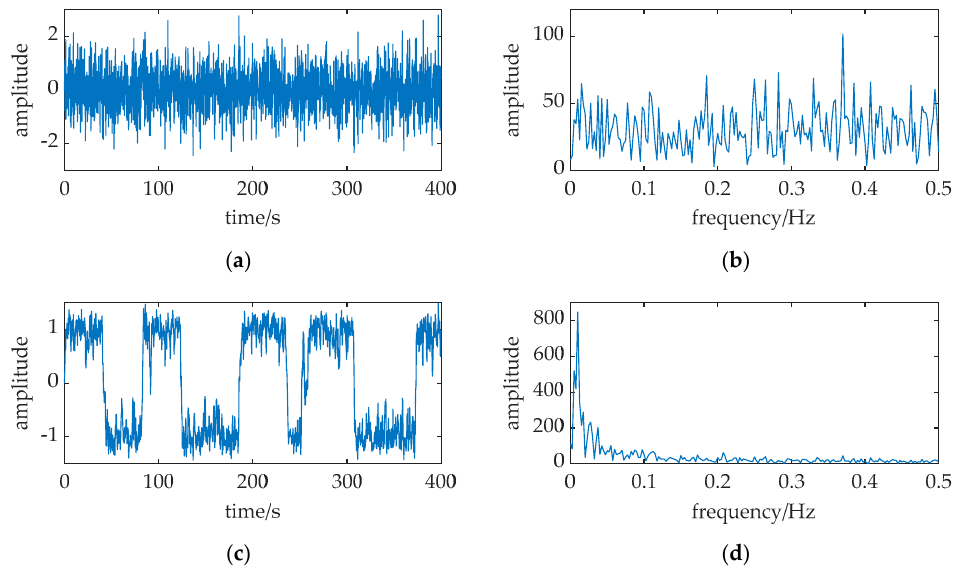
Figure 4. A simulation of classical SR. The relative parameters corresponding to Equation (7) configured as: A = 0.1, f = 0.01, a = 1, b = 1, D = 0.31, f s = 5. ( a , b ) are the waveform and frequency spectrum of the input; ( c , d ) are waveform and frequency spectrum of the SR output.